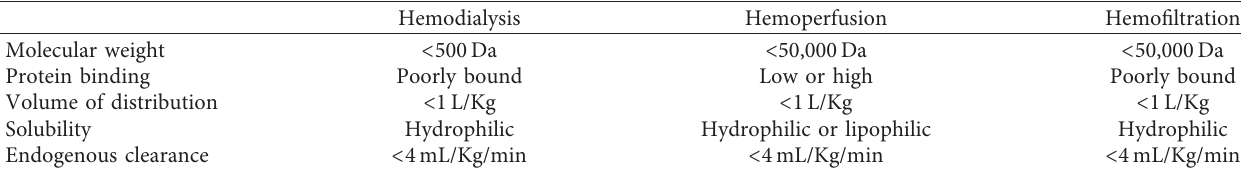
Table 1: Drug characteristics and the corresponding suitable dialysis method.